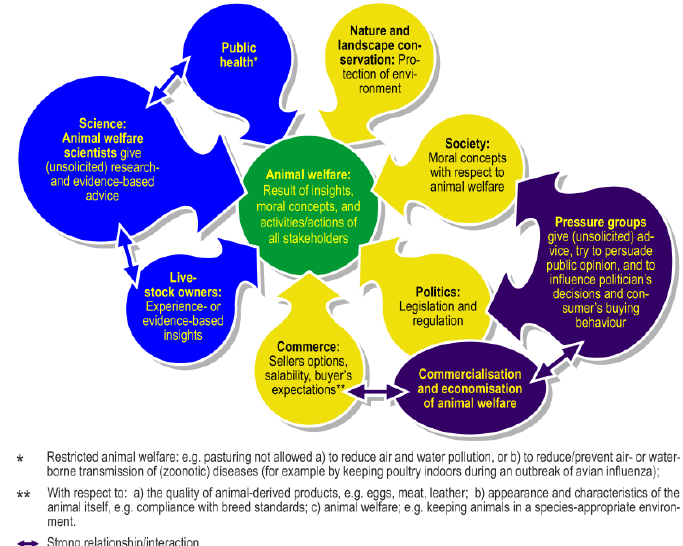
Figure 3. Stakeholders in animal welfare. Animal welfare is the result of (scientific) insights, of moral concepts of scientists and society at large [114–116], and of the activities and actions deployed by all stakeholders. Animal welfare scientists have an obligation to perform scientific research on animal health and welfare, to take action if animal welfare is compromised, and to give direction to future developments. Politicians are sensitive to the opinions and sentiments of pressure groups and society at large and may amend legislation and regulations. In parallel, the commercial value of animal welfare is increasingly being recognized and creates added value for many animal-derived products (e.g., [117]) and services. Note: Veterinarians are involved in ensuring public health, and they are the primary contact persons about animal health/welfare with livestock/animal owners.